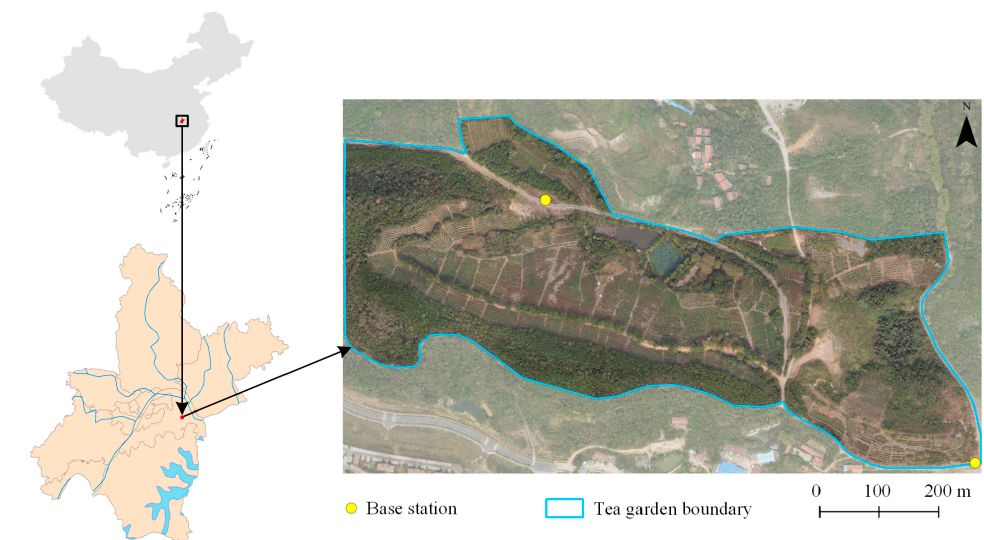
Figure 2. Location of the study area (the Huashan Tea Garden) in Wuhan City, China.